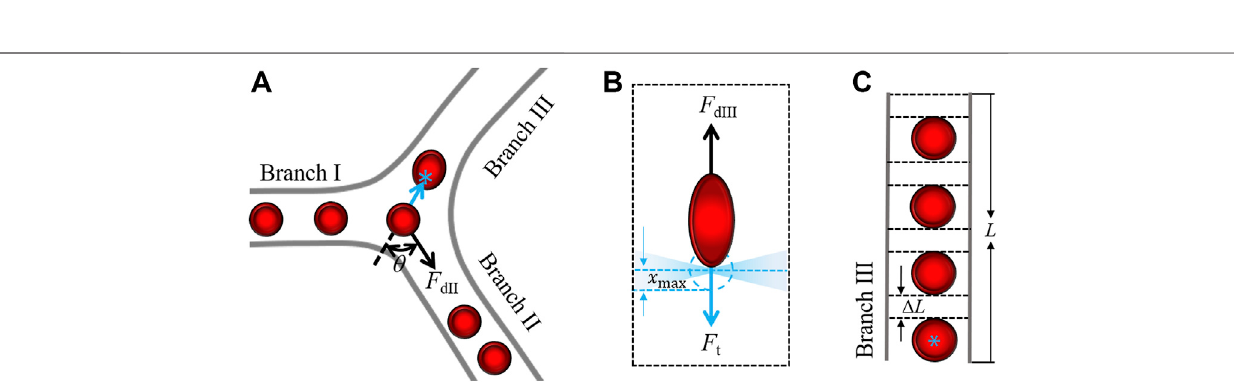
FIGURE 5 | (A) Optical tweezers control of blood fl ow in a branching microvessel. ‘ + ’ indicates the optical trap. (B) Relationship between laser power and reperfusion ef fi ciency ( η ).